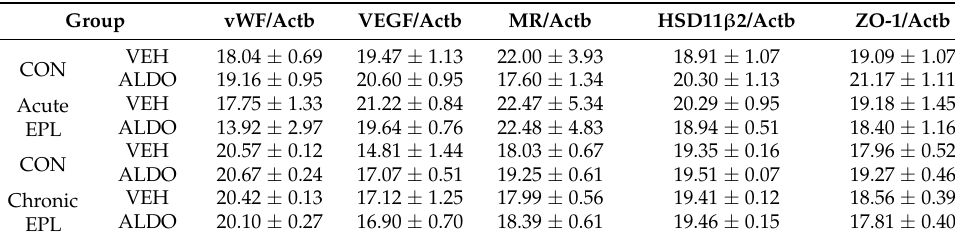
Table 1. Relative expression of the studied genes normalized to β -actin expression.